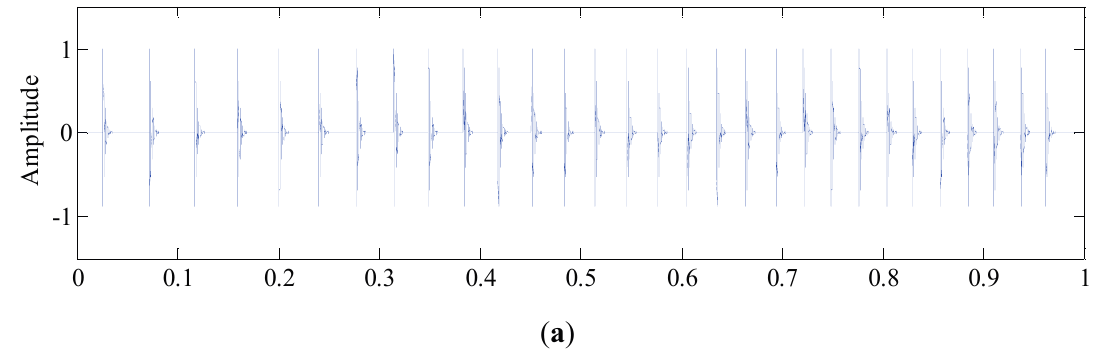
Figure 4. The simulated bearing vibration signal: ( a ) fault impulses p ( t ); ( b ) gear vibration g ( t ); ( c ) extraneous interferences e ( t ); ( d ) noisy compound signal x ( t